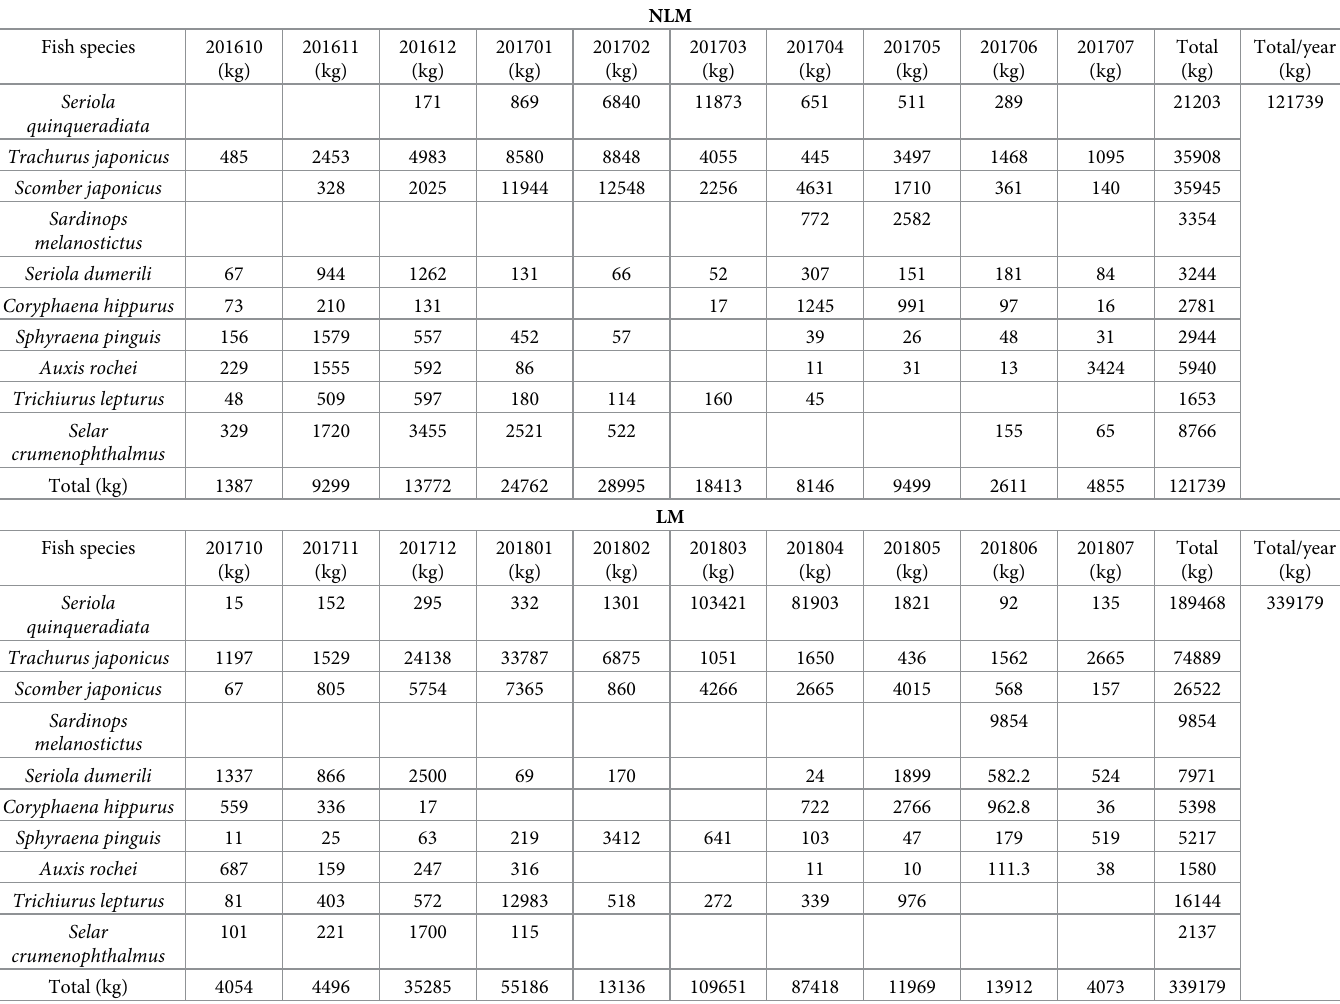
Table 3. Annual catch of each fish species in the set net (Top 10